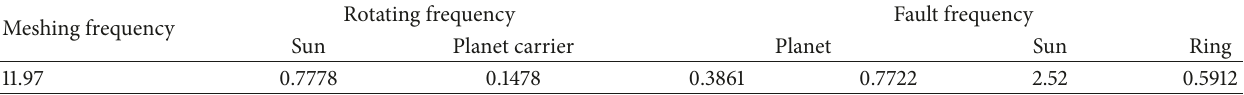
Table 2: Characteristic frequencies (Hz).